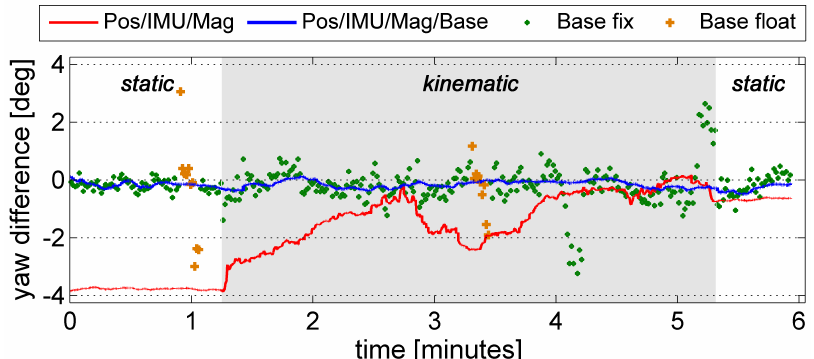
Figure 7. Difference of the GPS yaw angle (Base fix, Base float), the Pos/IMU/Mag/Base and the Pos/IMU/Mag yaw angle to the reference solution. The kinematic parts are marked with a gray